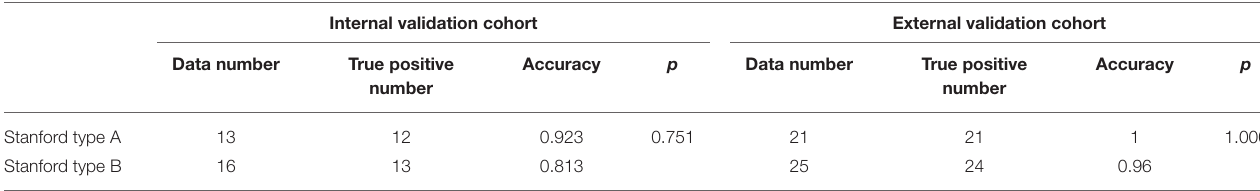
TABLE 4 | Accuracy comparison in the detection of AD with the Stanford type A and the Stanford type B in the two centers.